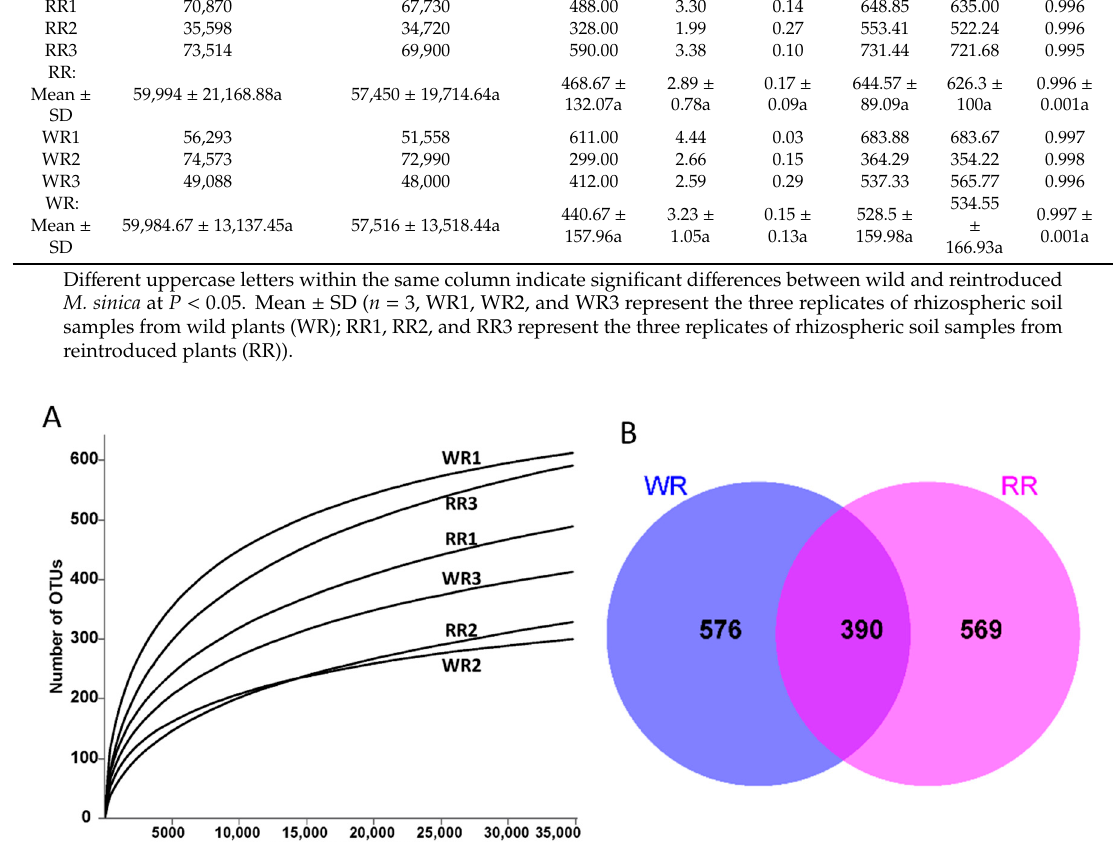
Table 2. Alpha-diversity analysis of the fungal ITS2 region obtained from rhizospheric soil samples from wild and reintroduced M. sinica .